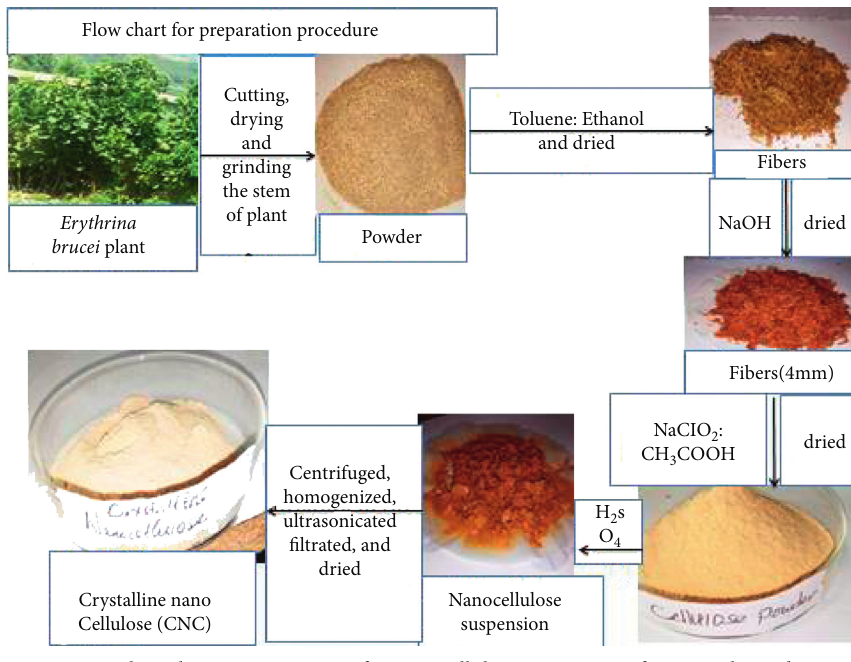
Figure 1: Flow chart representation for nanocellulose preparation from Erythrina brucei